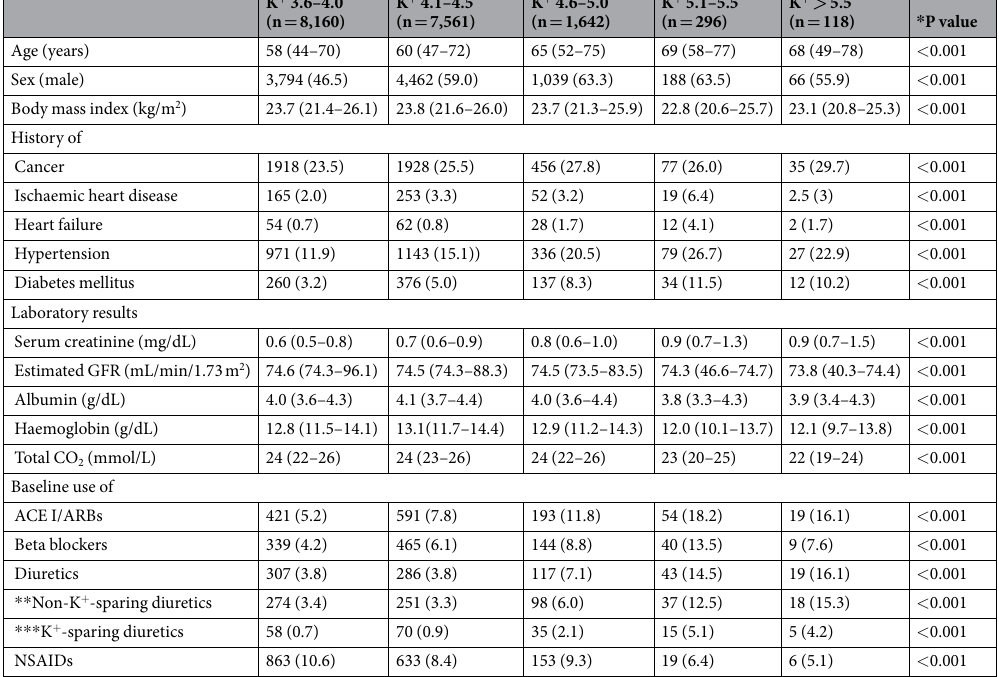
Table 1. Baseline characteristics according to baseline K + level. GFR, glomerular filtration rate, CO 2 , carbon dioxide, ACE I, angiotensin converting enzyme inhibitor, ARB, angiotensin receptor blocker, NSAID, non- steroidal anti-inflammatory drug. Values were presented as n (%) for categorical variables, and median (25% to 75% interquartile) for continuous variables (all data in the table showed non-normal distribution). * P for trend was calculated using the linear-by-linear association for categorical variables and Kruskal-Wallis test for one-way analysis of variance for continuous variables. ** Loop diuretics, thiazides, and carbonic anhydrase inhibitors.